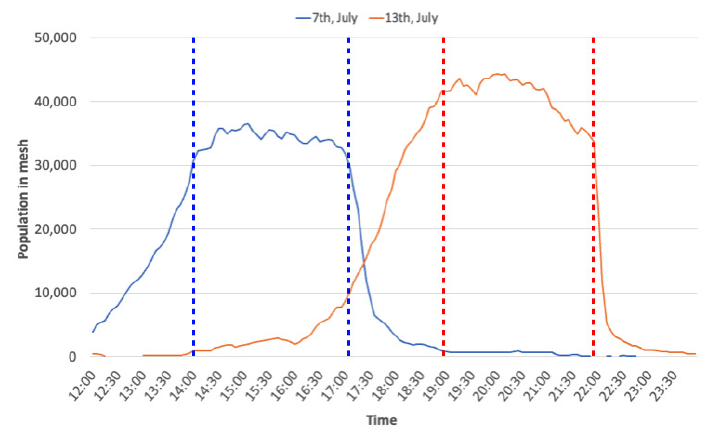
Figure 4. Time series of the observed population at the event